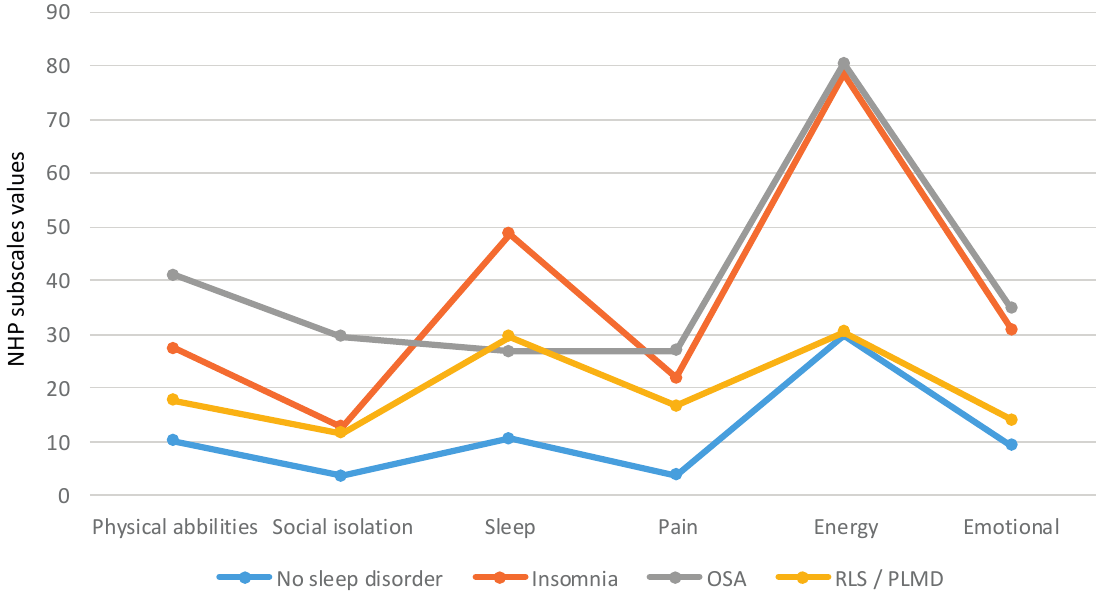
Figure 2. Subscales of the NHP in the different sleep disorders (mean